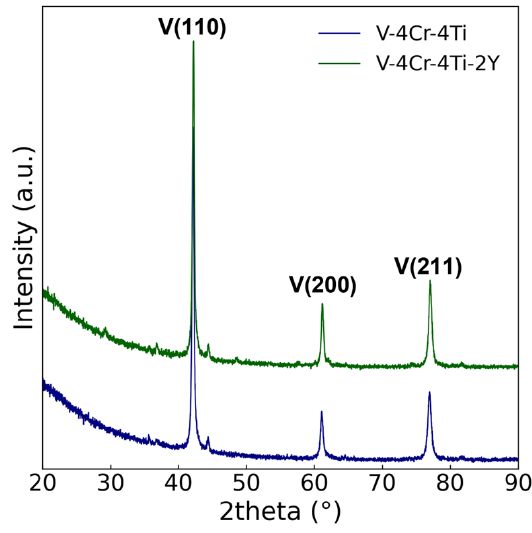
Figure 3. XRD patterns of V-4Cr-4Ti and V-4Cr-4Ti-2Y alloys.